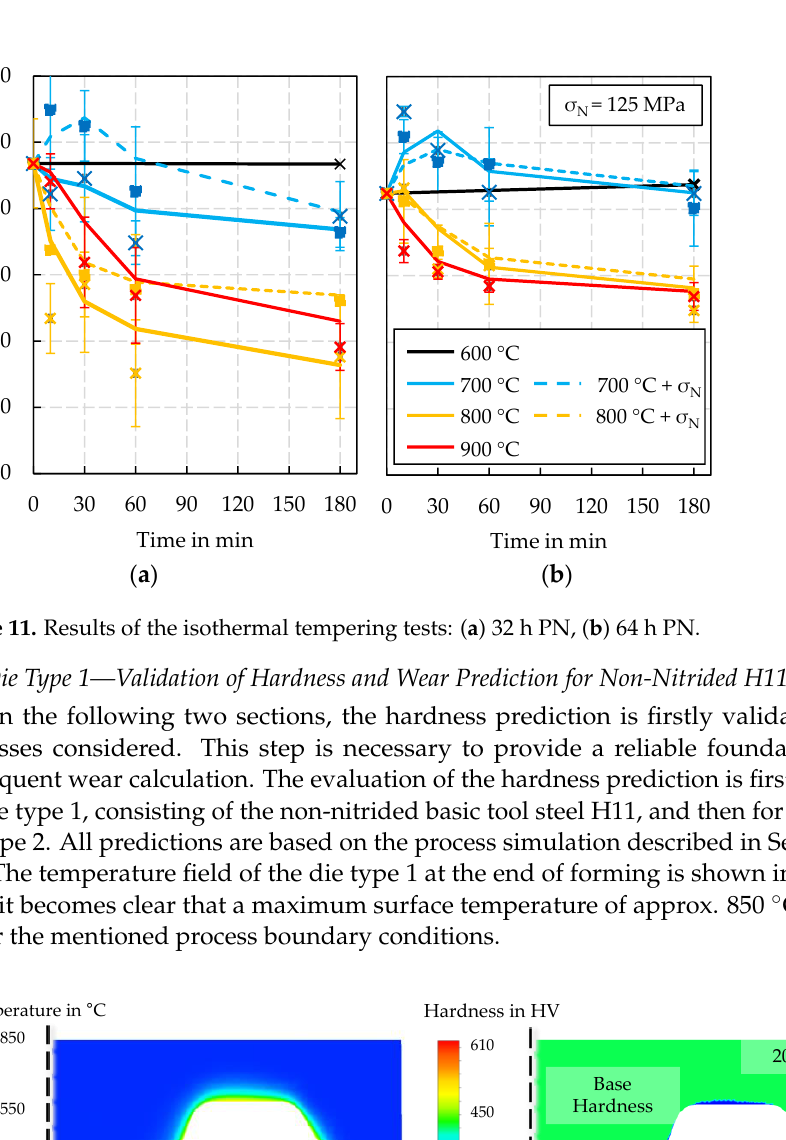
Figure 13. Experimental and numerical results of the hardness evolution after laboratory forging using die type 1.